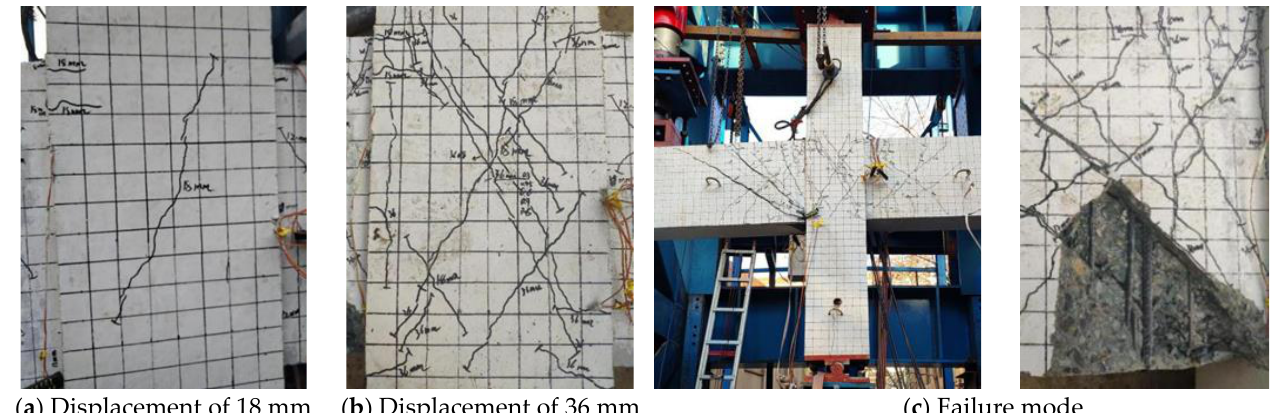
Figure 13. Crack development and failure of specimen ZJ-2A.